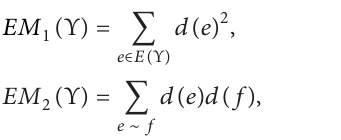
1: Generalized subdivision double corona ( X ) , Υ ( Y ) 􏼈 􏼉 Υ ( S ) ∘ Υ 1 2